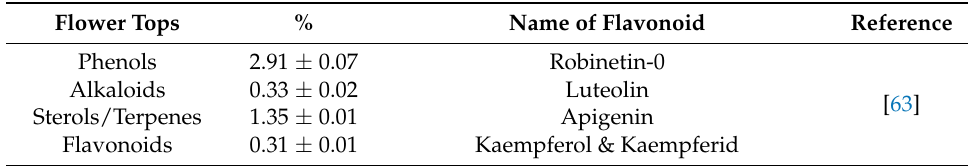
Table 2. Quantitative estimation (%) of chemical components and name of fraction of Flavonoids of flower tops of G. kurroo Royle.